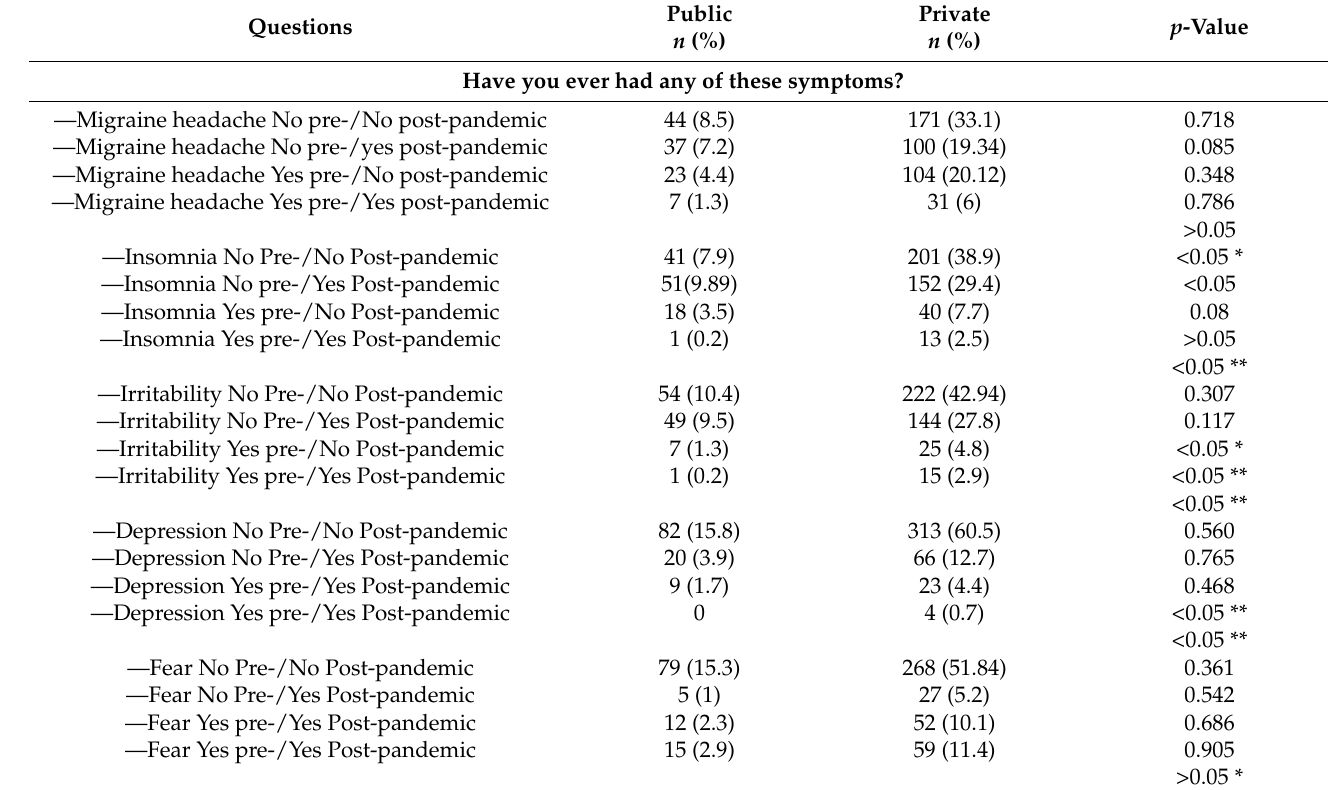
Table 5. General health during the pandemic